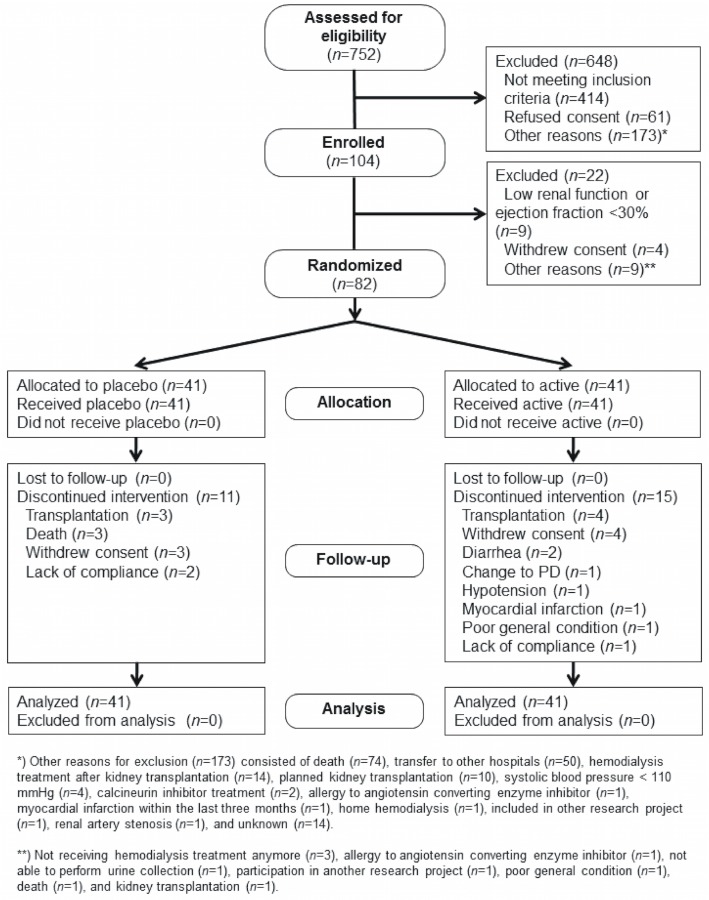
Consort flow diagram.This figure is reused from our previous publication [26]. Inclusion and exclusion criteria have been published previously [25]. Briefly, the main inclusion criteria were urine output >300 mL/day, dialysis vintage <1 year and left ventricular ejection fraction >30%. Absence of an AV-fistula was not an exclusion criterion since most patients were expected to obtain an AV-fistula during the study. Moreover, blood pressure and IDH episodes were monitored in all patients regardless of access modality. Time of dropout was not significantly different as previously reported [26].